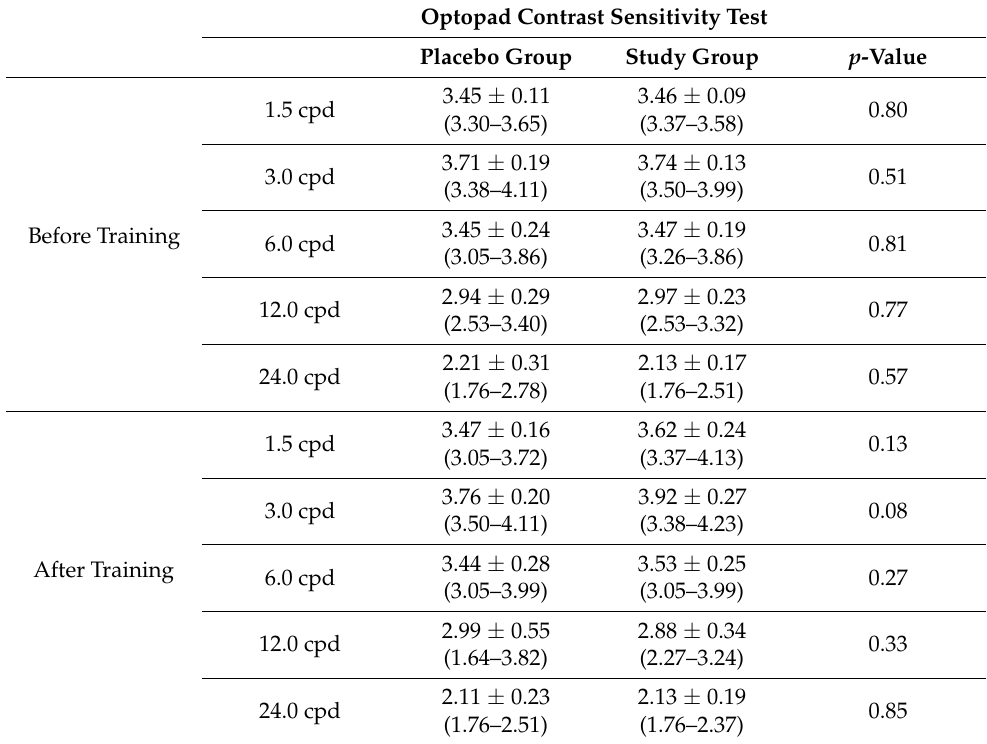
Figure 4. Distance contrast sensitivity values obtained with the CSV1000 test before (continuous lines) and after (discontinuous lines) the training in the placebo (green) and study groups (purple). Table 3. Near contrast sensitivity results obtained before and after the training with the Optopad test. Statistically significant differences ( p < 0.05) are marked with an asterisk (*).